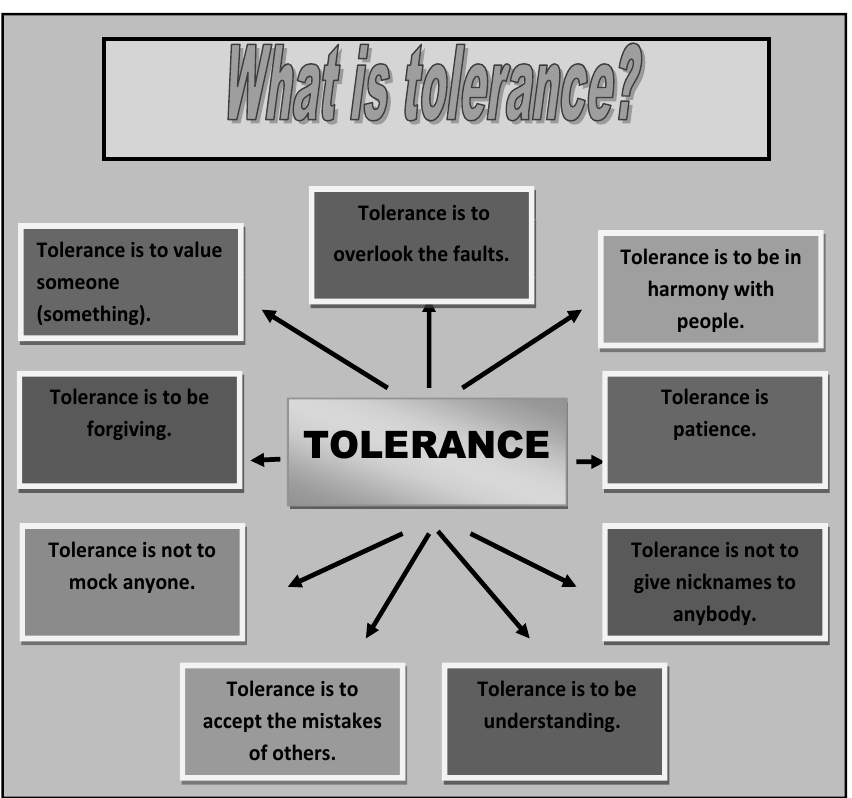
Figure 1. Mind map for